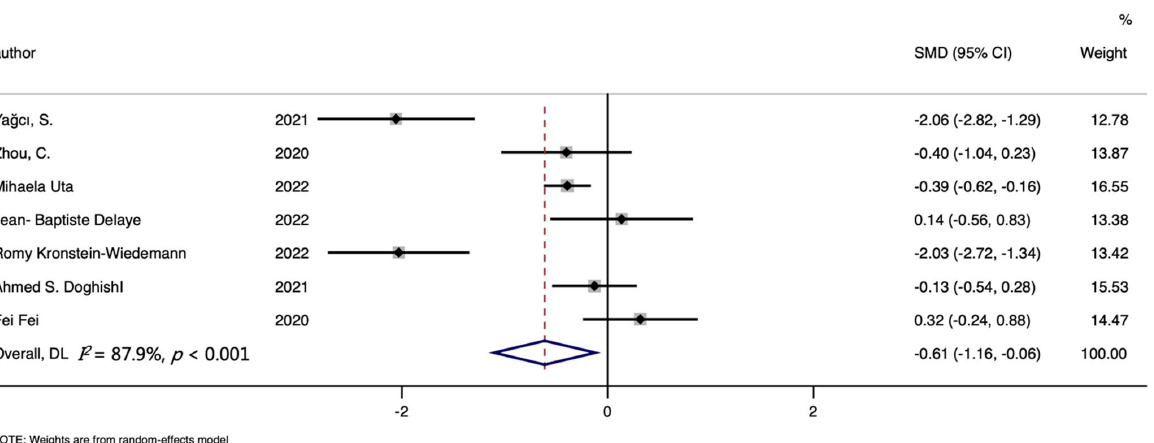
Figure 7. Forest plot of standard mean difference (SMD) with corresponding 95% confidence inter- vals (CIs) of studies[10,17–19,24,36,37] on hemoglobin levels in COVID-19 cases and controls. The solid diamond and horizontal line represent the study-specific effect and 95%CI, respectively; the size of the grey square is positively correlated with the weight distributed to each study in the meta- analysis. The center of open diamond with the vertical dashed line expresses the pooled SMD, and the width expresses the pooled 95%CI.